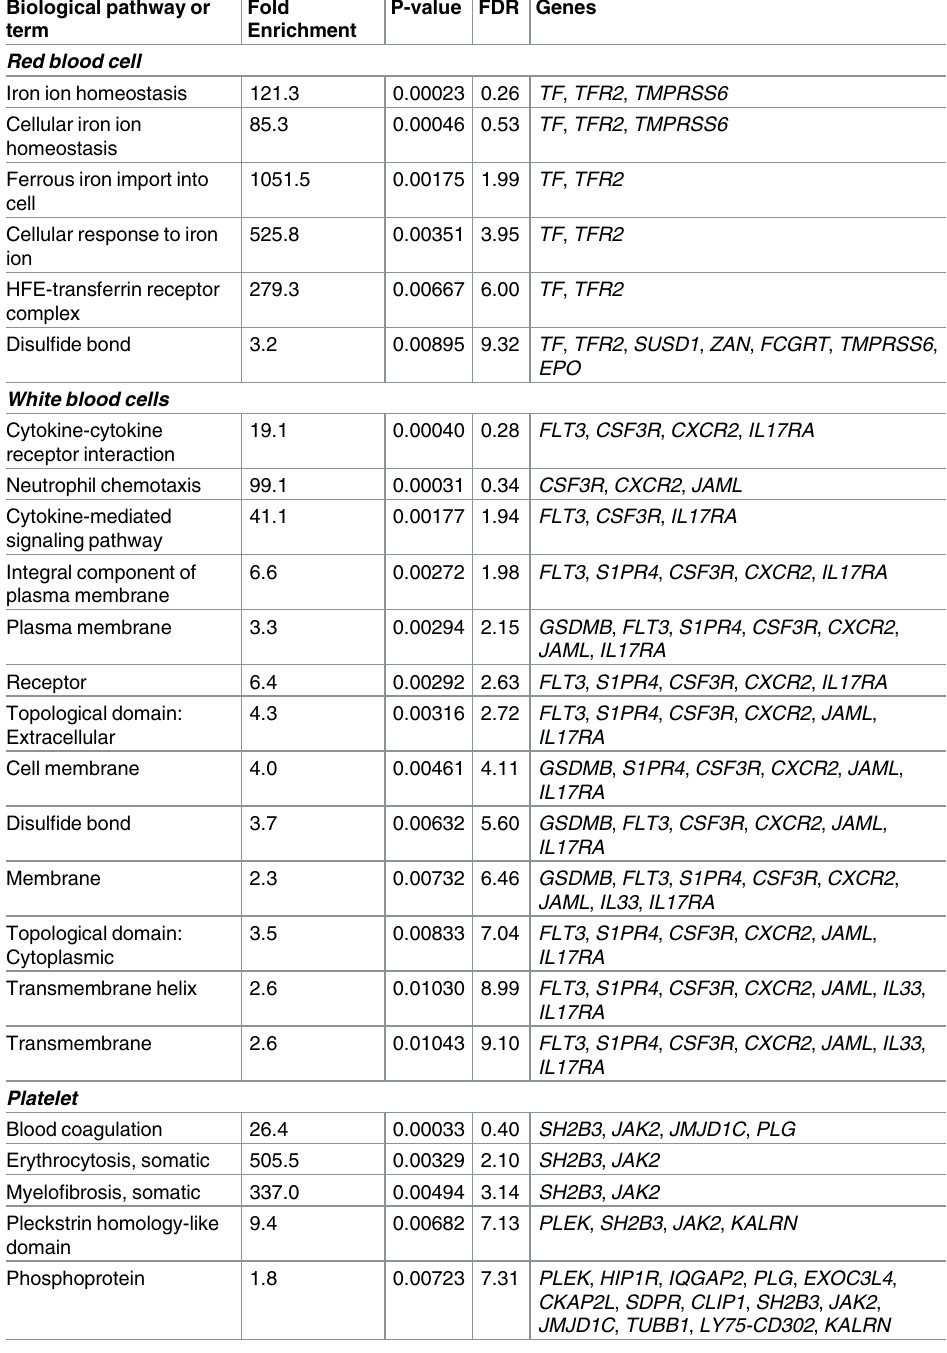
Table 4. Pathway analysesusing DAVID with genes that carry rare coding or splice site variants asso- ciated with blood-cell traits. We only present biological pathways with a false discovery rate (FDR) < 10%. Biological pathway or